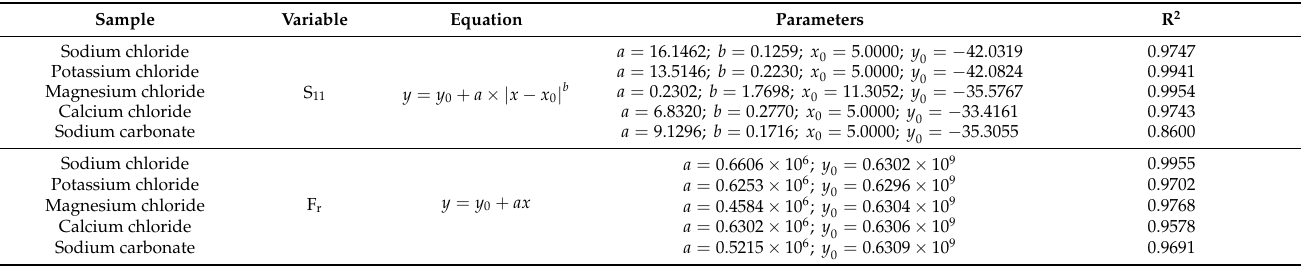
Table 3. The equations and parameters of this relationship for each salt in the frequency range of the second resonance